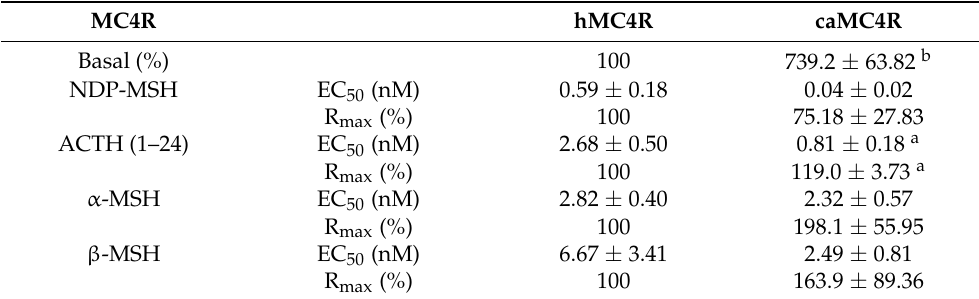
Figure 8. Signaling properties of caMC4R. HEK293T cells were transiently transfected with MC4R plasmids, and the intracellular cAMP levels were measured 48 h later via radioimmunoassay. Dif- ferent concentrations of NDP-MSH ( A ), ACTH (1–24) ( B ), α -MSH ( C ), or β -MSH ( D ) were used to stimulate HEK293T cell. Data were expressed as mean ± SEM from triplicate measurements within one experiment. The curves were representative of at least three independent experiments. Table 2. The signaling properties of